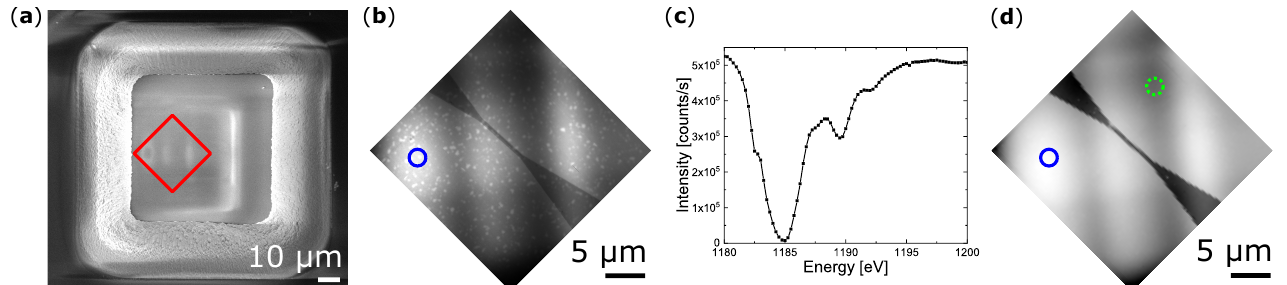
Figure 3. Comparison of transmissivity between electrons and soft X-rays of a Ga-doped YIG film grown on GGG. ( a ) Scanning electron micrograph at 10 kV. ( b ) STXM image of the detail indicated by the red square in (a) taken at the Fe L 3 edge. ( c ) X-ray transmission spectrum at the Gd M 5 edge taken at the thinnest position indicated by the blue circle in (b). ( d ) Logarithmic transmittance of the window taken at 1150 eV. The blue and dotted green circles indicate the points for the thickness